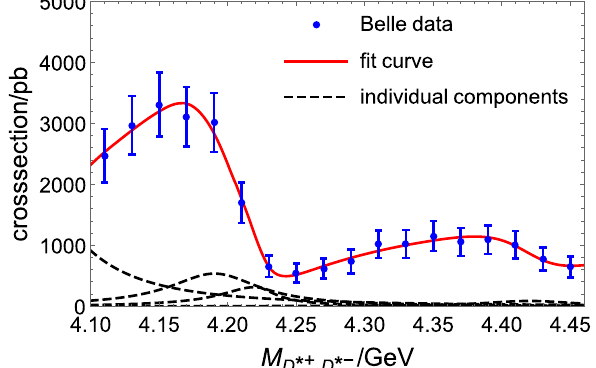
Fig. 5 Given the complex coherent background in D ∗+ D ∗− process, the fit result of the D ∗+ D ∗− cross section. The blue dots come from Belle results [25]. The solid curve is the projection from the best fit. The dashed curves show the individual components of ψ( 4040 ) , ψ( 4160 ) , X ( 4260 ) and ψ( 4415 ) , respectively. The contribution of the complex